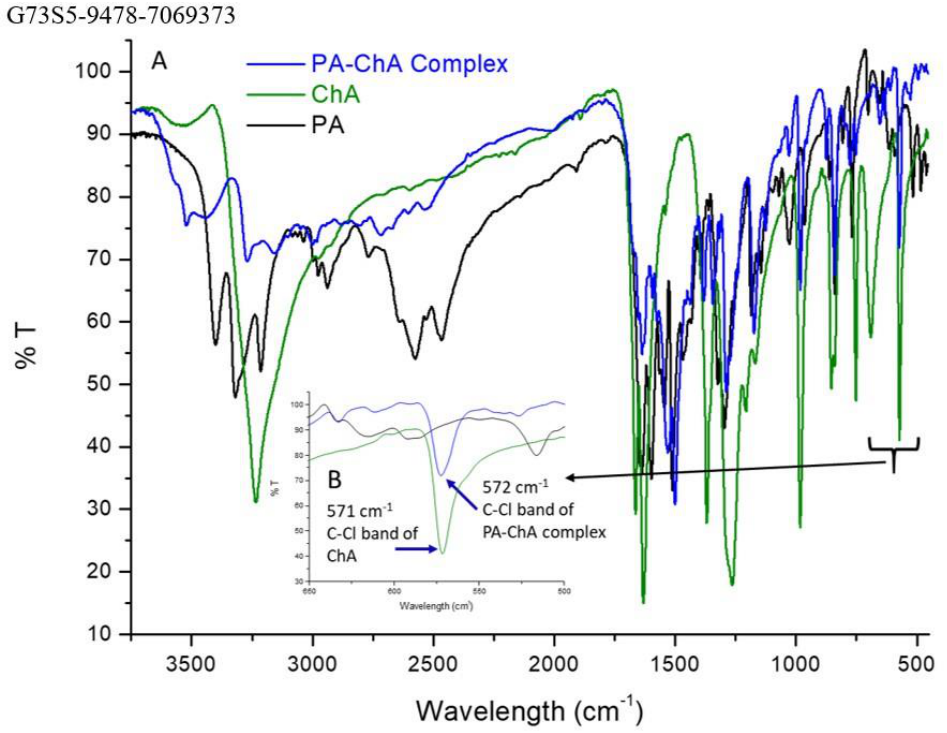
Figure 5. Comparison of IR spectra of procainamide (PA), chloranilic acid (ChA), and PA-ChA complex: ( A ) whole spectra; ( B ) showing the characteristic C-Cl band of ChA and PA-ChA complex. Table 2. IR spectral bands of PA, ChA, and their complex (PA-ChA).